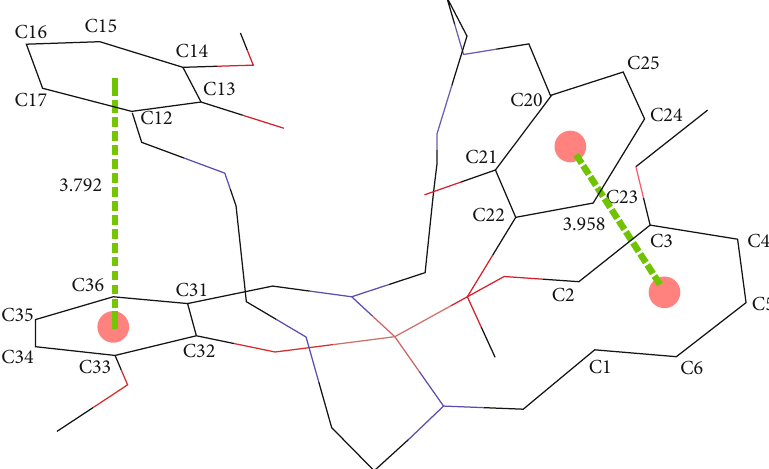
Figure 4: pi – pi interaction between phenyl rings in Cu(H the center of